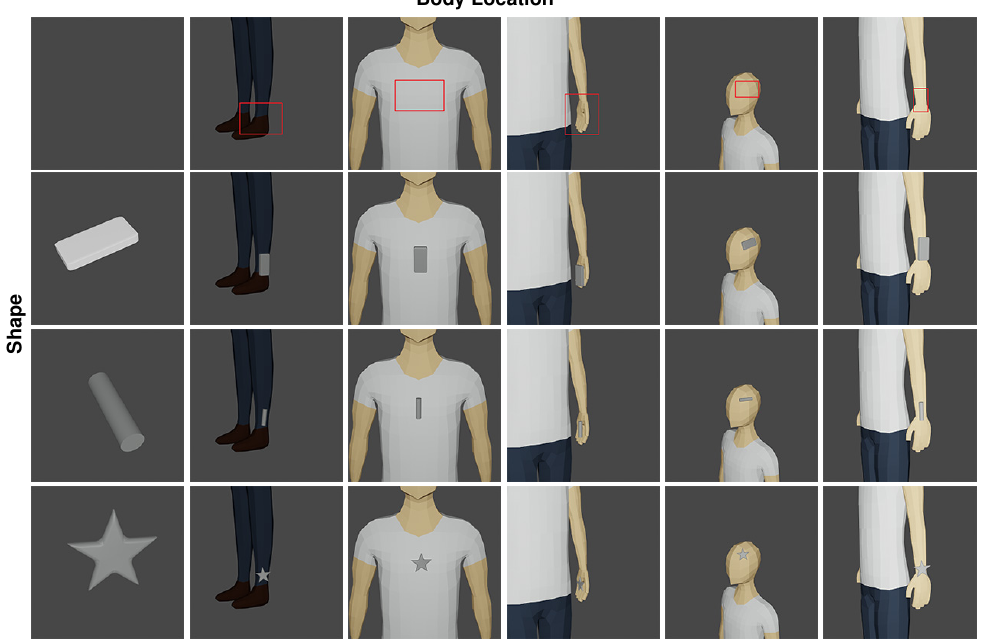
Figure 1. Stimuli in our study used to investigated the stereotypical perception of shape and body location: any , squared , cylindrical , and star as variations of shape (rows). Ankle , any , chest , hand , head , and wrist for different body locations